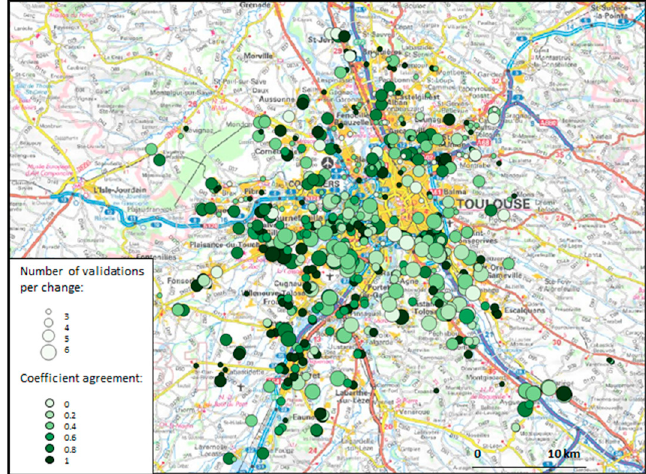
Figure 10. The number of validations and the coefficient of agreement values per change (Basemap: 25k topographic map from Geoportal©IGN).